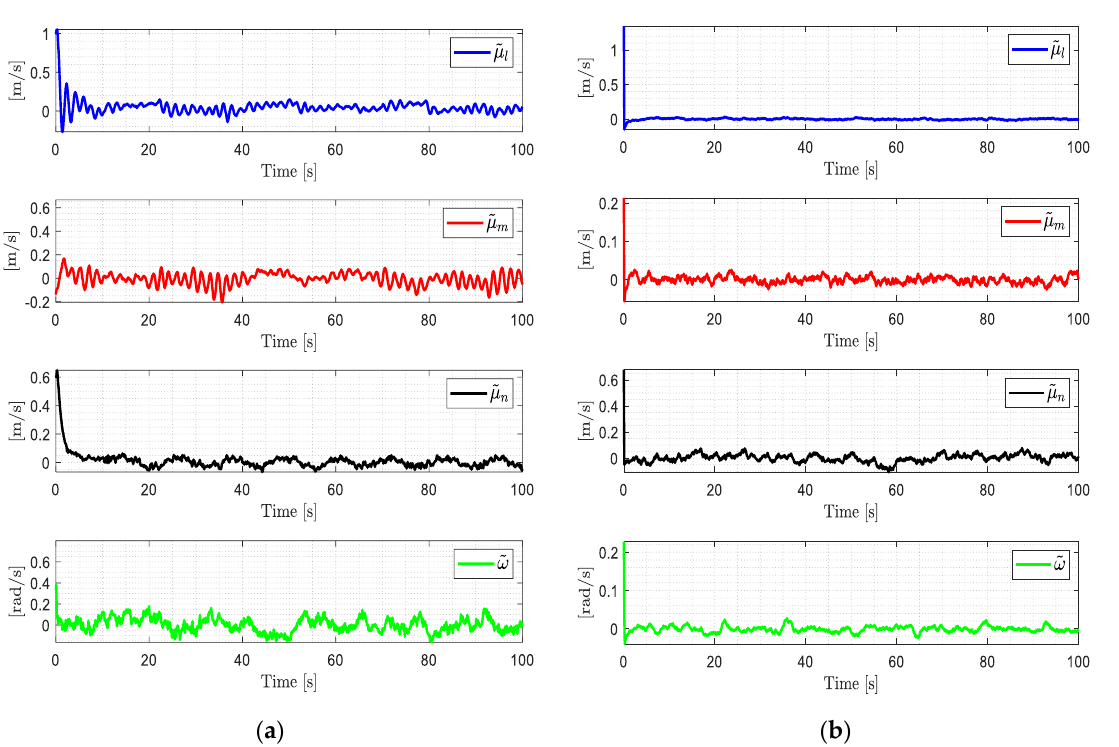
Figure 11. Position errors ( ) control errors.